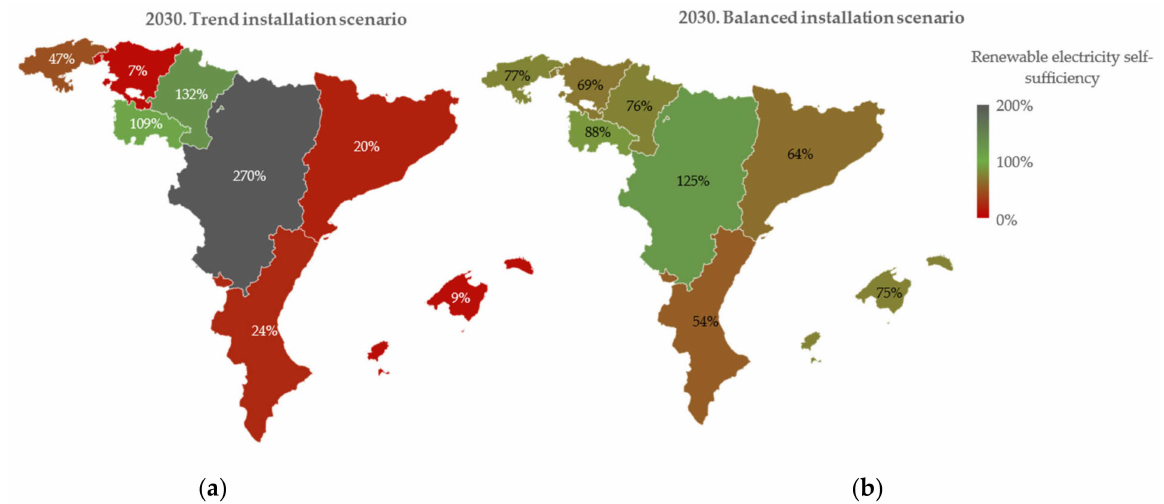
Figure 7. Renewable electricity self-sufficiency in 2030. ( a ) Trend scenario; ( b ) balanced scenario. The trend scenario for 2030, based on the current nameplate capacity installation trend and PNIEC goals, expects that the Bioregion imports 11.5 TWh of electricity by 2030, 9% of its demand, showing unbalances between electricity production and